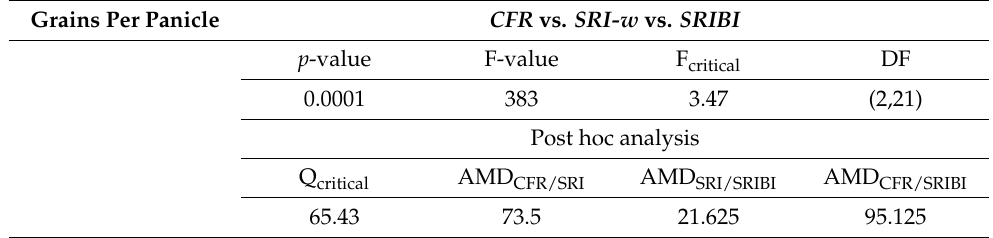
Table 9. Parameters from ANOVA statistical analysis for filled grains per panicle (FGPP) comparison. Grains Per Panicle CFR vs. SRI-w vs.